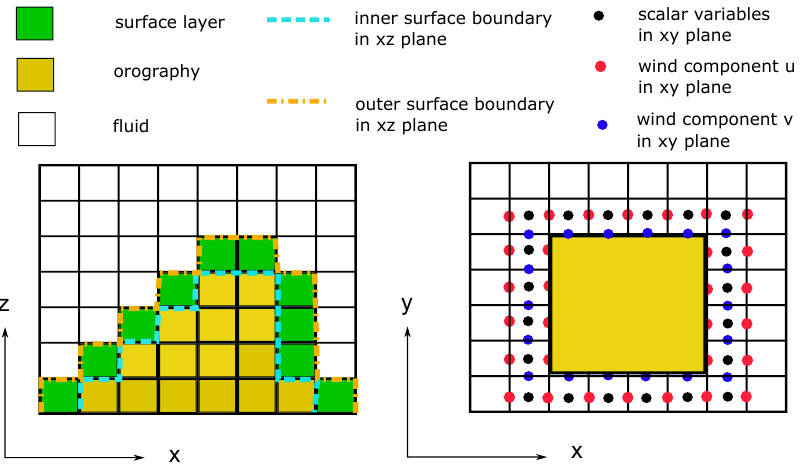
Figure 2. Sketch of the Cartesian topography in PALM. The yellow cells represent orography, the white cells indicate fluid cells and the surface layer adjacent to orography are displayed in green on xz plane. The light blue lines represent the inner surface boundary of the surface layer on xz plane, while the orange lines defines the outer boundary on xz plane . According to the definition of the staggered C-grid, the black points on xy plane represent cell centres, where scalar variables are masked. The locations of u and v wind components displayed in red and blue define the location of impermeable orography